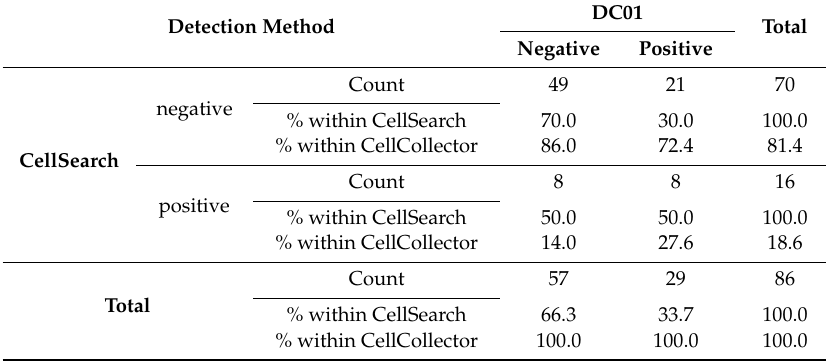
Table 4. CTC (circulating tumor cell) counts of all samples (from both sampling time points) explored by the two